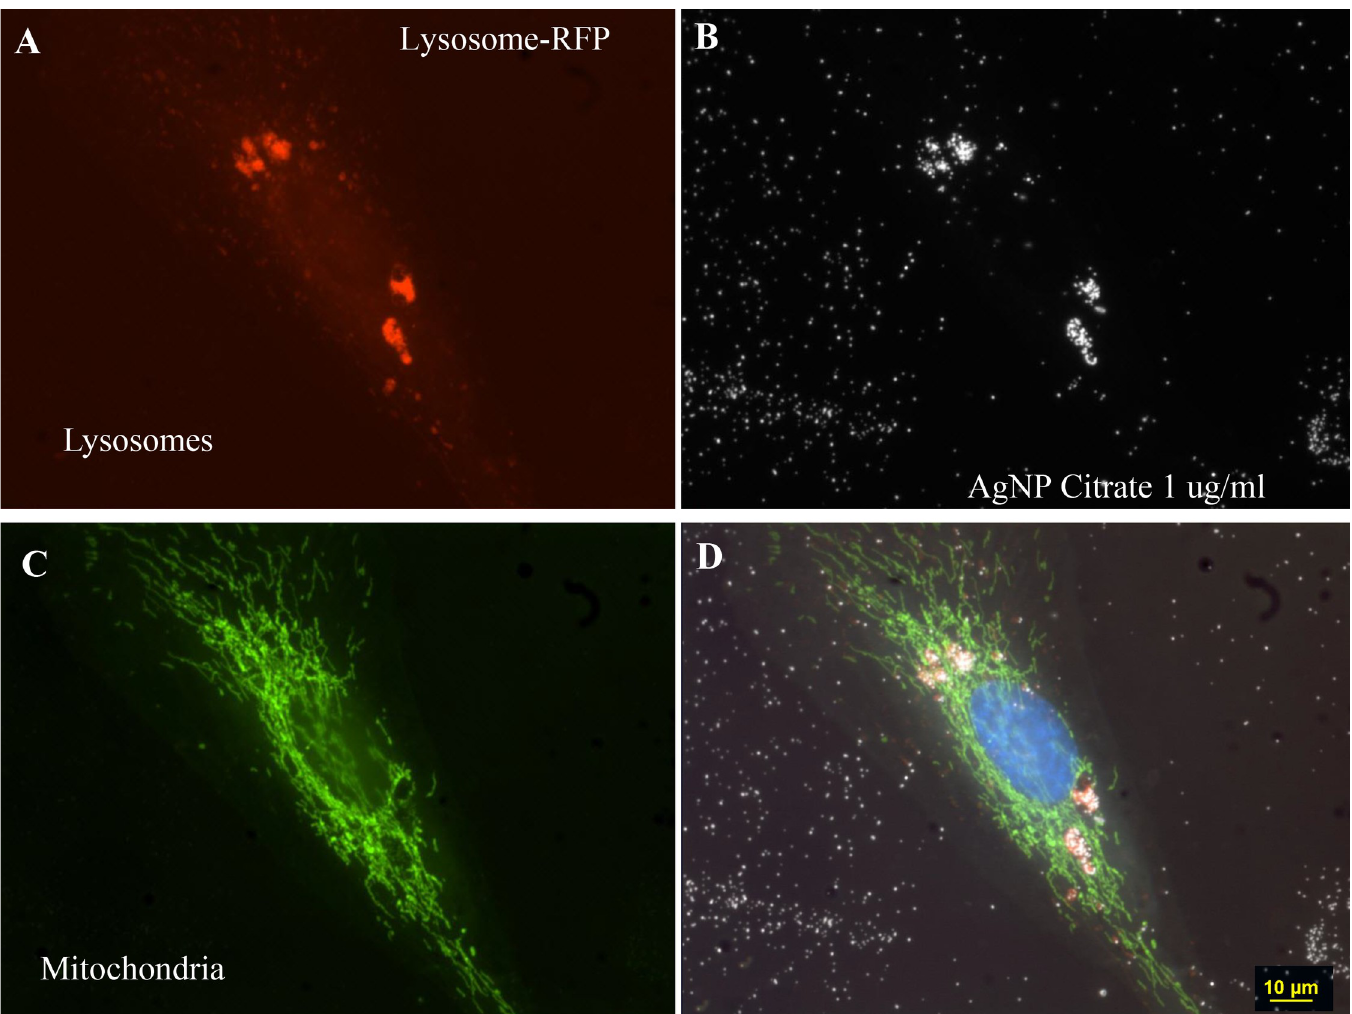
Fig 7. Four different fields of 3ug/ml AgNP citrate obtained with darkfield optics using a 60-x plan Fluor objective with an iris diaphragm (NA 0.55–0.90). Panel A. Cells were stained with Lysosome- RFP (red) to reveal the lysosomes. Panel B. Intracellular nanoparticles (white) were condensed into the identical regions occupied by lysosomes in A. Panel C. Cells transfected with Mito-GFP (green). Panel D. A composite image of fields A, B, and C were combined with DAPI stained nuclei (blue). Magnification 600x.